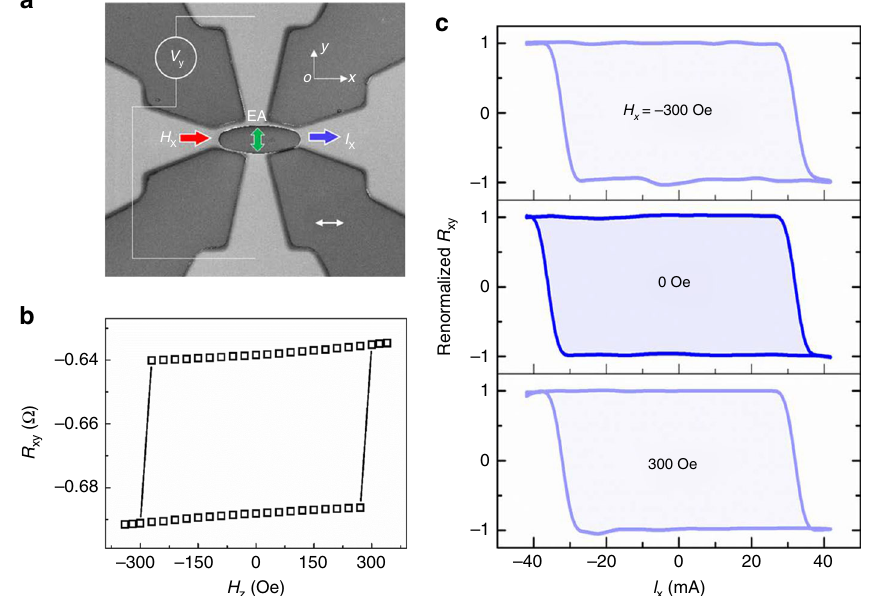
Fig. 3 Characteristics of Type-T mode. a Scanning electron microscope image of a Hall bar device. Scale bar: 10 μ m. b H z dependence of R xy of the device. c Current dependence of renormalized R xy = ( R xy + 0.663 Ω )/0.025 Ω under different fi eld H x which is parallel to